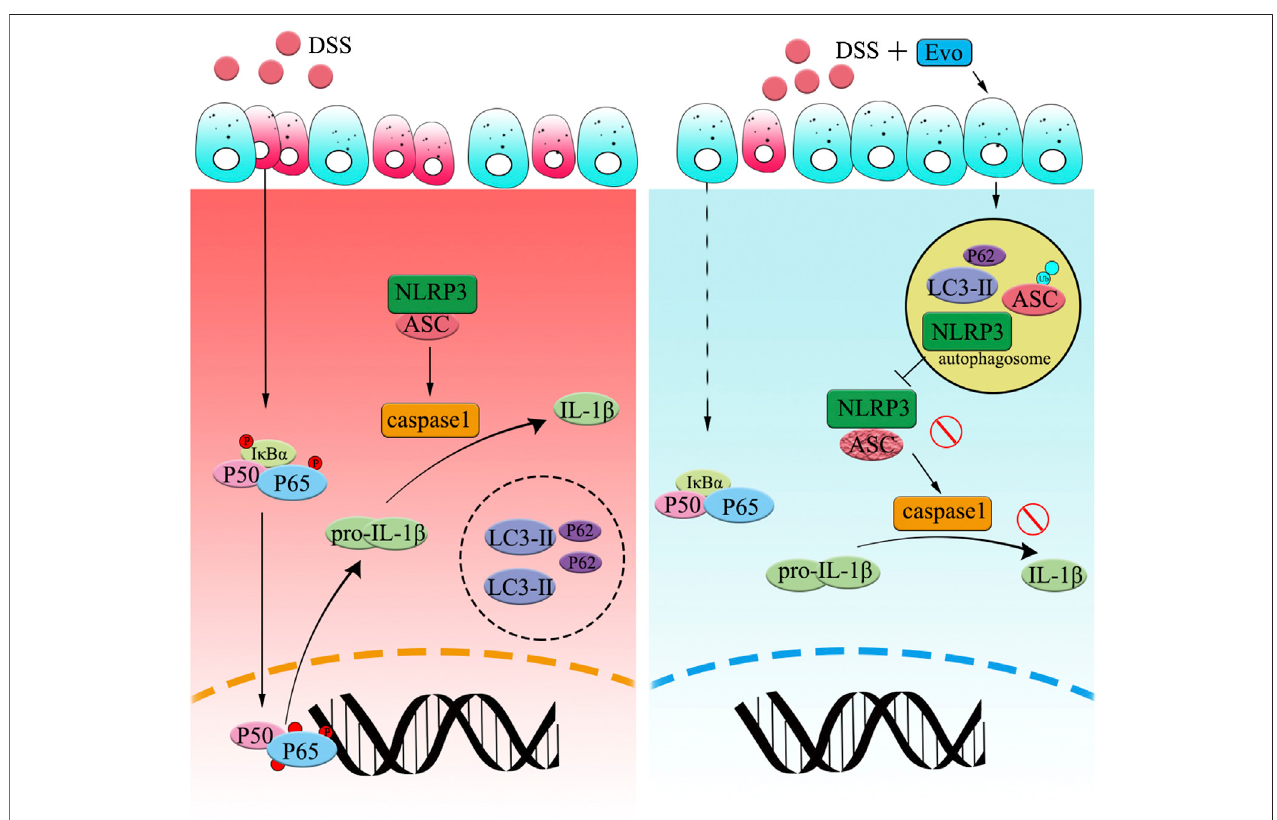
FIGURE 7 | Graphical Abstract | Evodiamine ameliorates ulcer colitis through the activation of autophagy and the inhibition of NLRP3 in fl ammasome assembly. Under the conditionofacutein fl ammationinducedbyDSS,NLRP3in fl ammasomeisactivated,autophagywasblocked,therebytheclearanceofpro-in fl ammatoryisimpaired. Evodiamine activates autophagy, leads to autophagosomal degradation of pro-in fl ammatory cytokine upstream of the NF κ B signaling cascade. Moreover, the assembly ofNLRP3 in fl ammasome wasalso suppressed byevodiamine duetotheinhibitionofASC. Asaresult, theproductionofin fl ammatory cytokinesuchasIL- 1 β decreased and colitis was